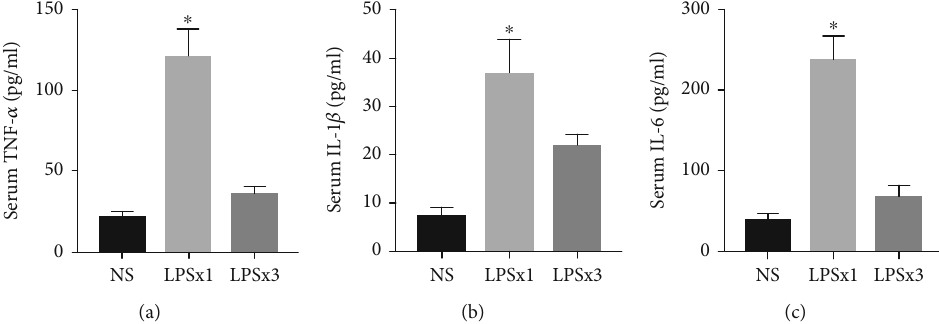
Figure 3: Serum cytokine changes following LPS injection. ELISA showed increased TNF- α , IL-1 β , and IL-6 levels following one dose of LPS injection. However, repeated LPS injections abolished TNF- α , IL-1 β , and IL-6 production. Data represent mean ± SEM ; n = 6 /group. ∗ P < 0 : 05 vs. NS group. LPS: lipopolysaccharide; NS: normal